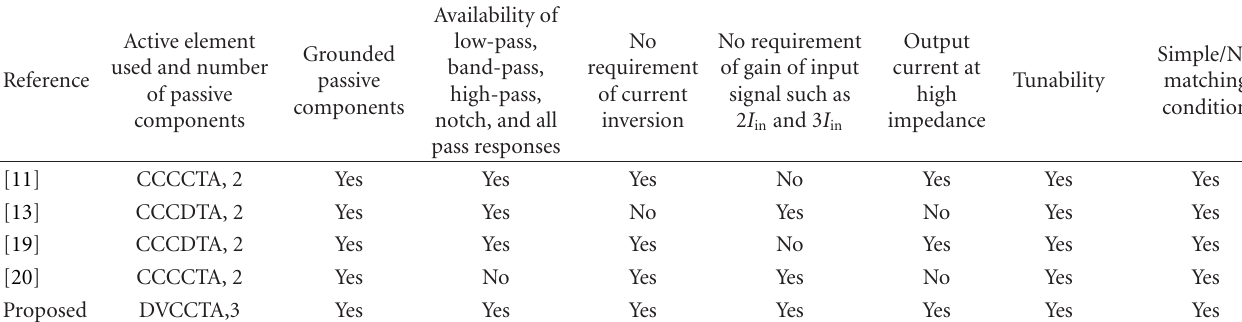
Table 5: Comparative study of the available similar type of single active element based CM